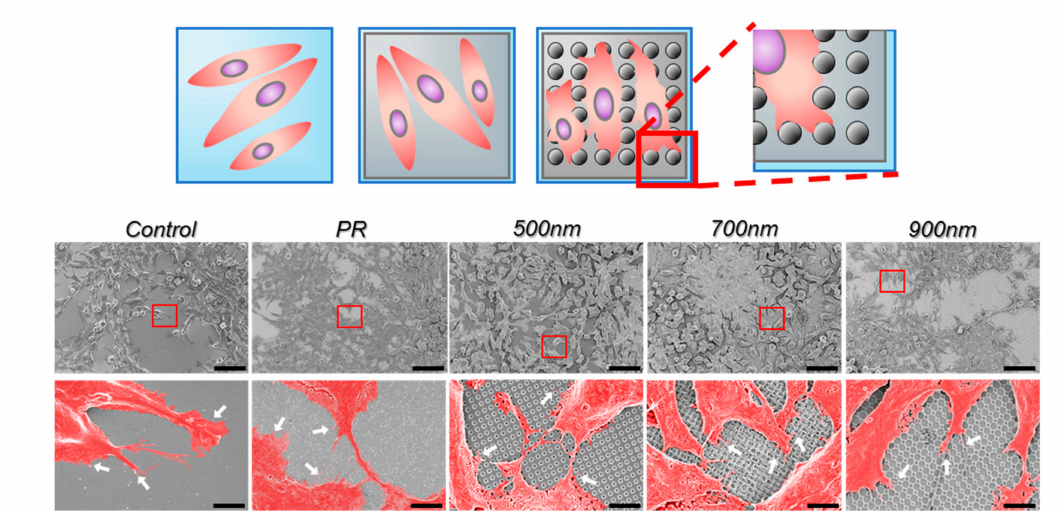
Figure 4. Pseudo-colored scanning electron microscopy (SEM) images of mNSCs showing cell spreading and filopodia after 4 d of cultivation on HNPAs with di ff erent hole size and non-patterned groups. Arrows indicate the filopodia projections toward nanoholes on the underlying substrates. Scale bars in top panel = 50 µ m; Scale bars in bottom panel = 5 µ m; Control = bare ITO substrate; red boxes: enlarged area; white arrows: